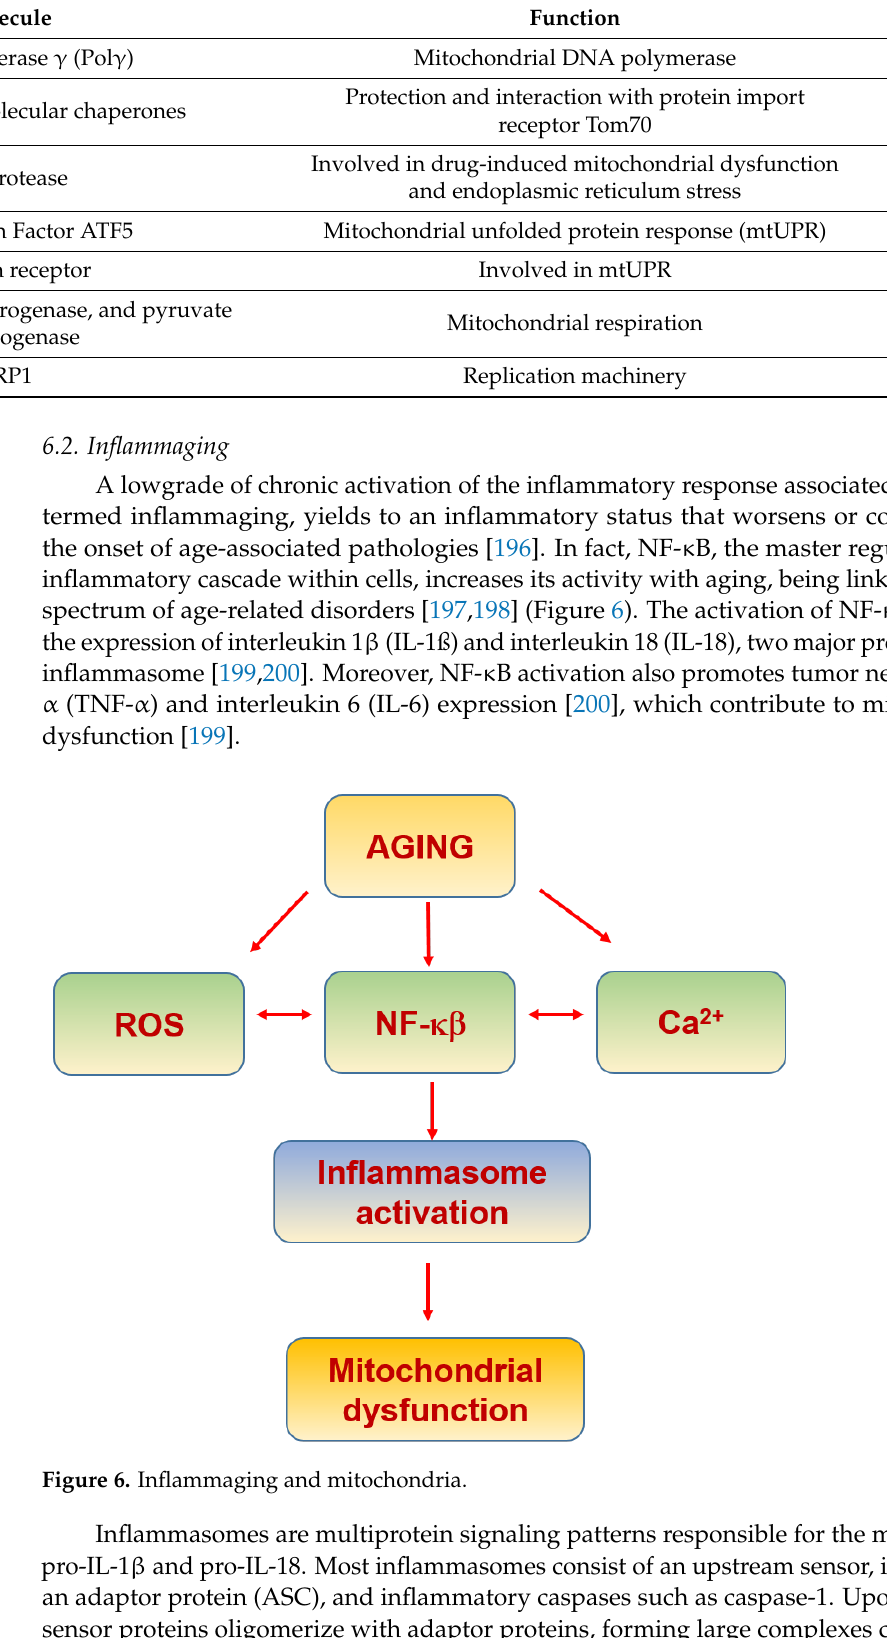
Table 1. Proteins involved in mitochondrial dysfunction in aging.